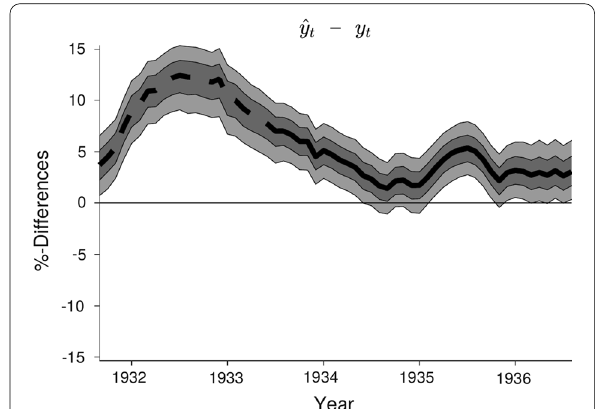
Fig. 5 Estimated Gain of Leaving Gold in September 1931/July 1933. Results are based on 5000 draws from the posterior distribution. Light-gray shaded area represents 95 % probability bands, dark-gray shaded area represents 68 % probability bands, black line represents median